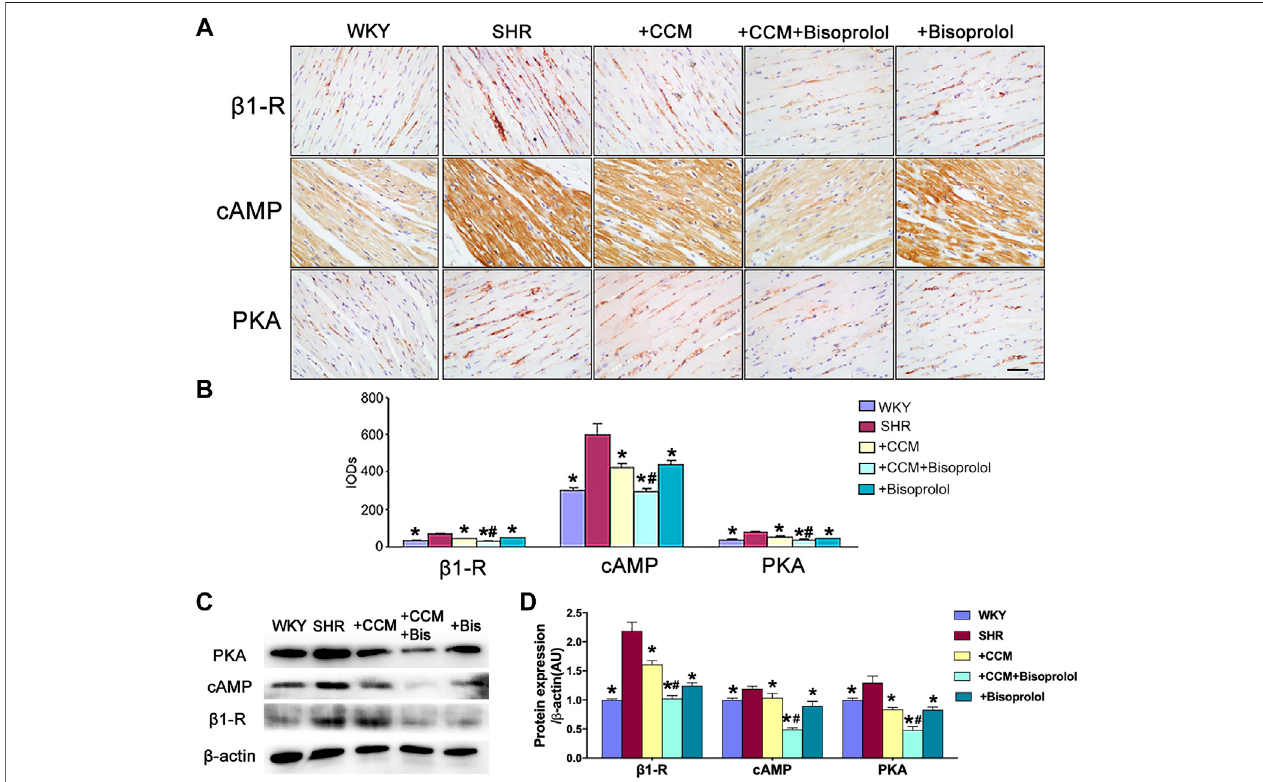
FIGURE 5 | CCM therapy inhibits β 1/cAMP/PKA signaling in SHRs hearts. Male SHRs at the age of 8 – 12 weeks old fed with normal diet received bisoprolol administration (5 mg/kg/day) or plus CCM therapy for 10 weeks. Wistar rats served as control. (A,B) Immunohistochemistry and quantitative analysis of β 1/cAMP/PKA signaling in hearts. scale bar:200 μ m. (C,D) Western blot and quantitative analysis of β 1/cAMP/PKA signaling in hearts. Quantitative results are expressed as mean ± SEM. N is 10 – 15 in each group. * p < 0.05 vs. SHRs. # p < 0.05 vs. SHRs plus